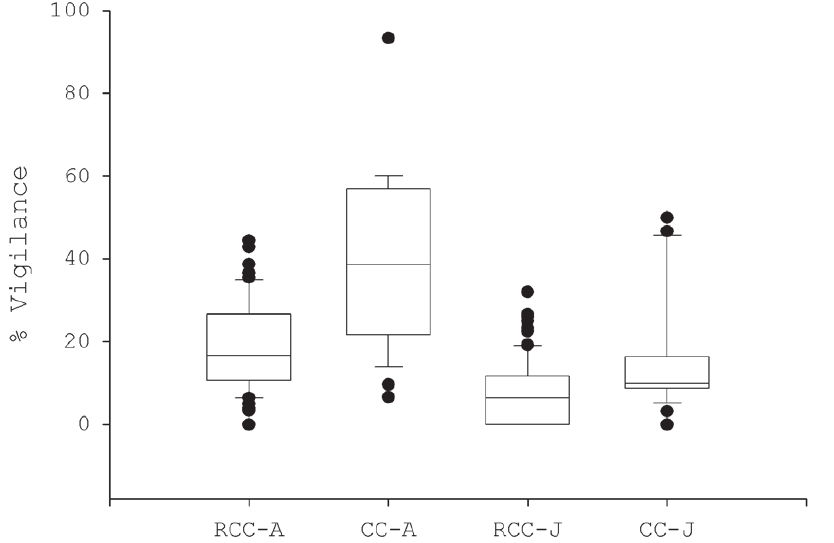
Figure 1. Percentage of scans with vigilance in family flocks of two crane species. Vigilance is shown for adults (A) and juveniles (J) in red- crowned crane (RCC) and common crane (CC).